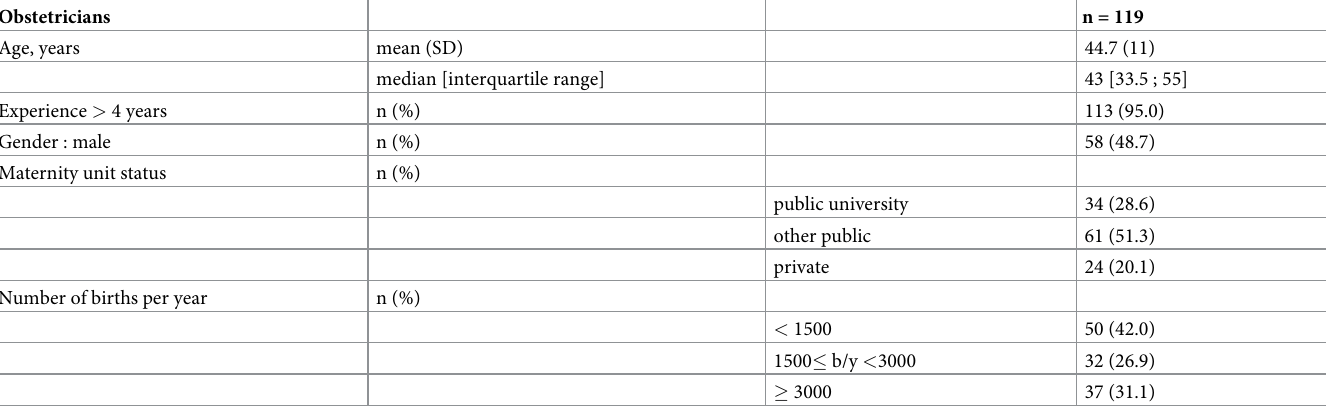
Table 1. Characteristics of obstetricians and maternity